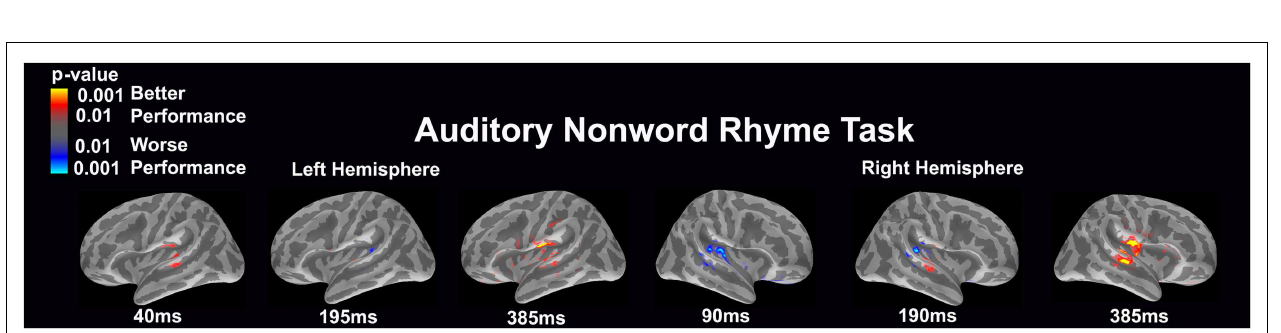
FIGURE 5 | Performance-dependent activation of neural pathways during the auditory non-word rhyme task is shown . Red represents activation associated with better performance while blue represents activation